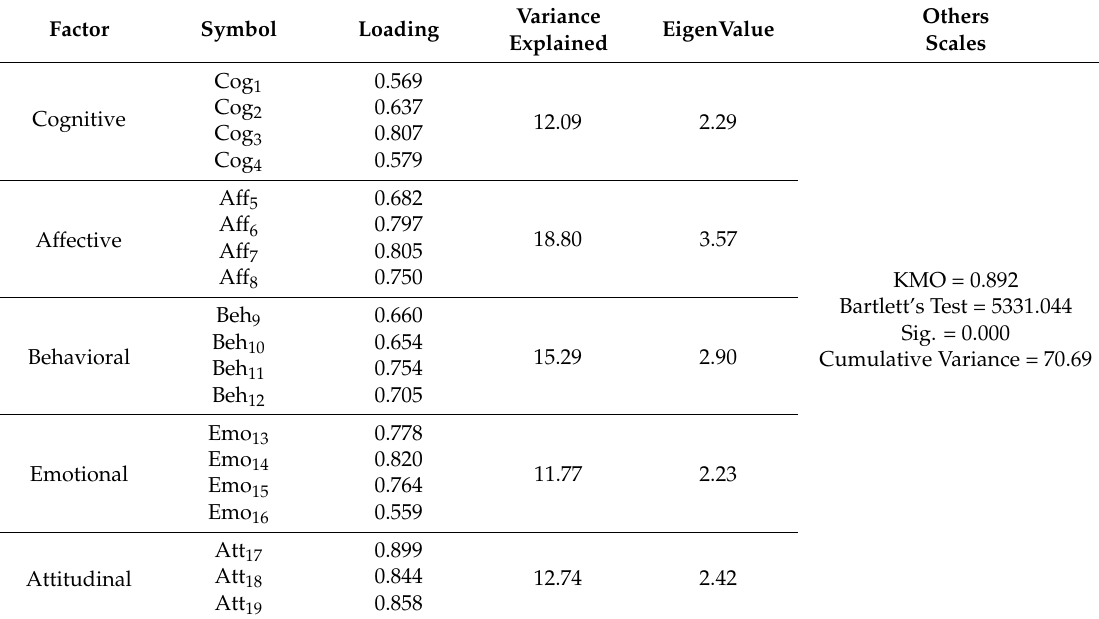
Table 6. Exploratory factor analysis of organizational cynicism and organizational pride.